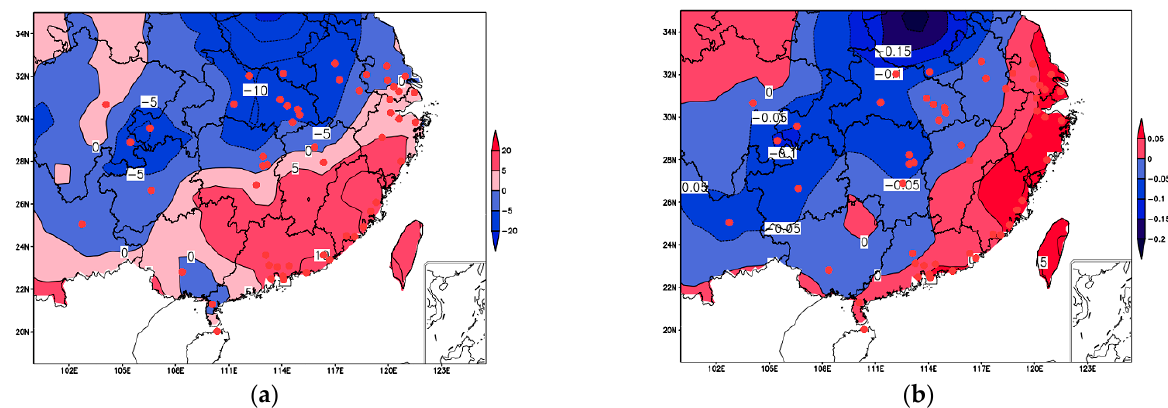
Figure 3. A contour plot of the 17-year, warm-season trend using 0.125° × 0.125° ECMWF data: ( a ) CAPE (J·kg − 1 ·year − 1 ), ( b ) total column water vapor (kg·m − 2 ·year − 1 ).